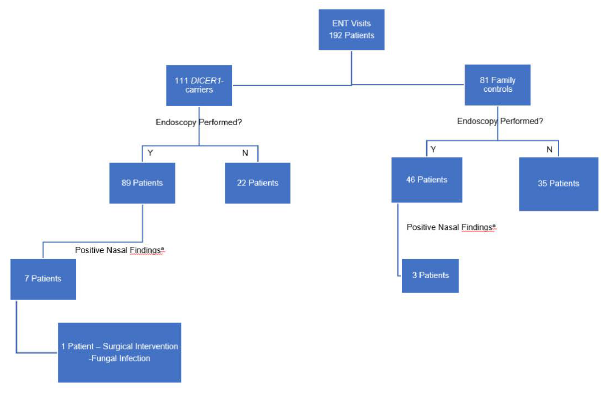
Supplementary Figure 1. Flow diagram describing nasal findings during nasal endoscopy in DICER 1 -carriers and family controls. a. Positive Nasal Findings = polyps, polypoid tissue, or yellow-colored rhinorrhea.